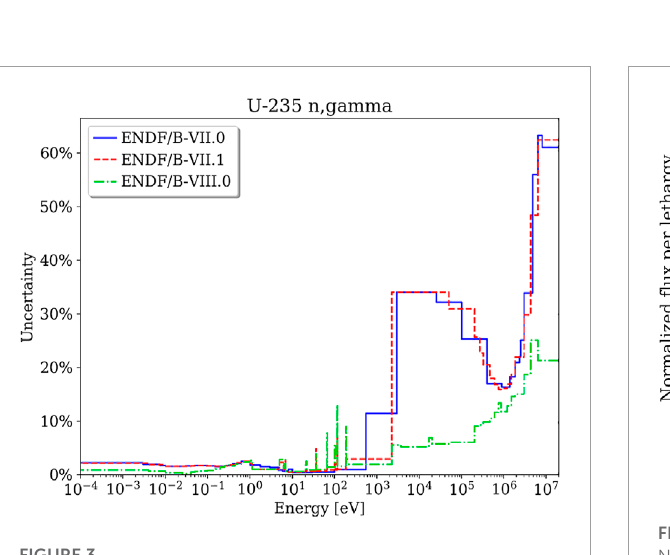
FIGURE 3 Relative uncertainty of the 235 U (n, γ ) cross section in different ENDF/B library releases.